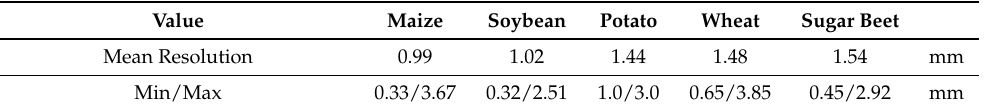
Table 2. Estimated spatial resolutions based on the leaf point clouds in Figure 8. Mean resolution is computed by averaging all nearest neighbor distances. The minimum and maximum values describe the lowest and largest distance that has been